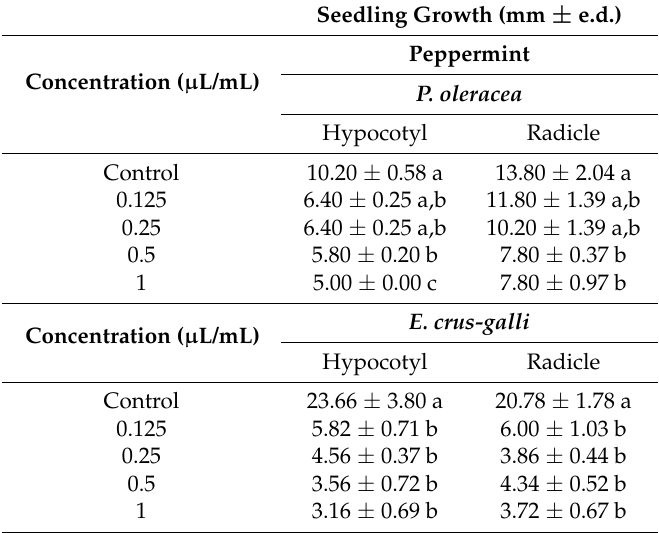
Table 3. In vitro effects of peppermint essential oil against P. oleracea and E. crus-galli seedling